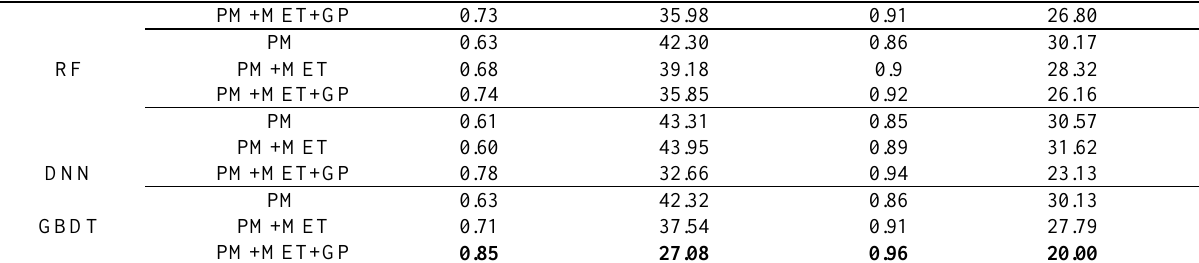
Table 2 . Performance statistics of the STAR model under different simulation functions and predictors.